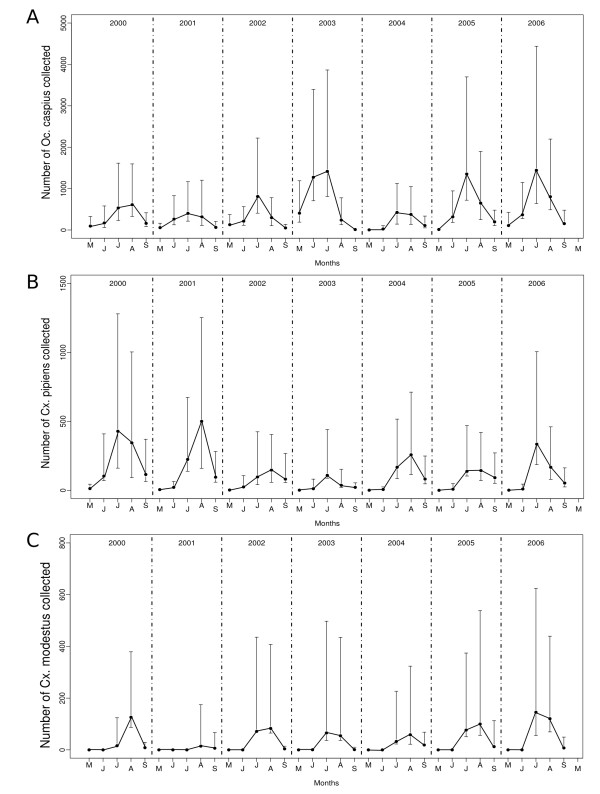
Median Number of adult mosquitoes collected in 36 CO2-baited traps placed in the study area from 2000 to 2006. (A) Oc. caspius, (B) Cx. pipiens, and (C) Cx. modestus. Values in graphs represent the median (black dots) and interquartile interval (error bars).